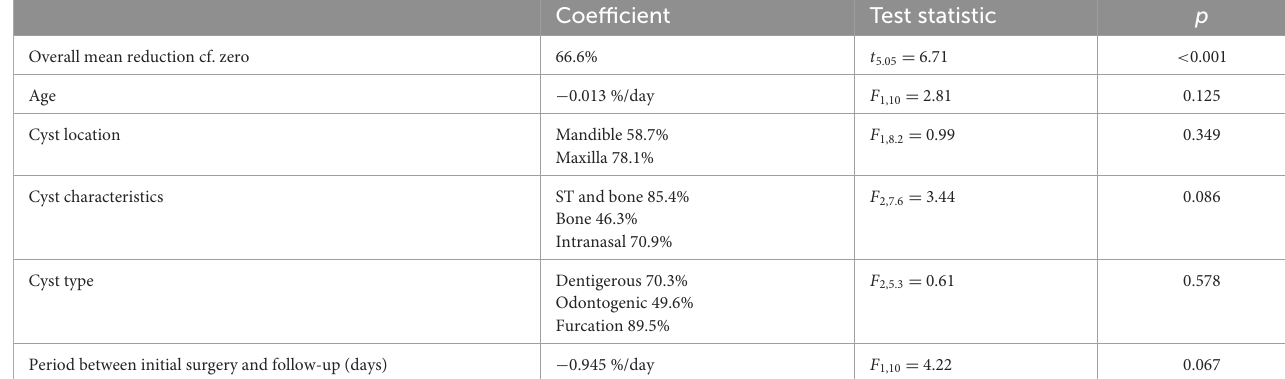
TABLE 2 Initial analysis of overall reduction in volume and the influence of five potential factors on volume